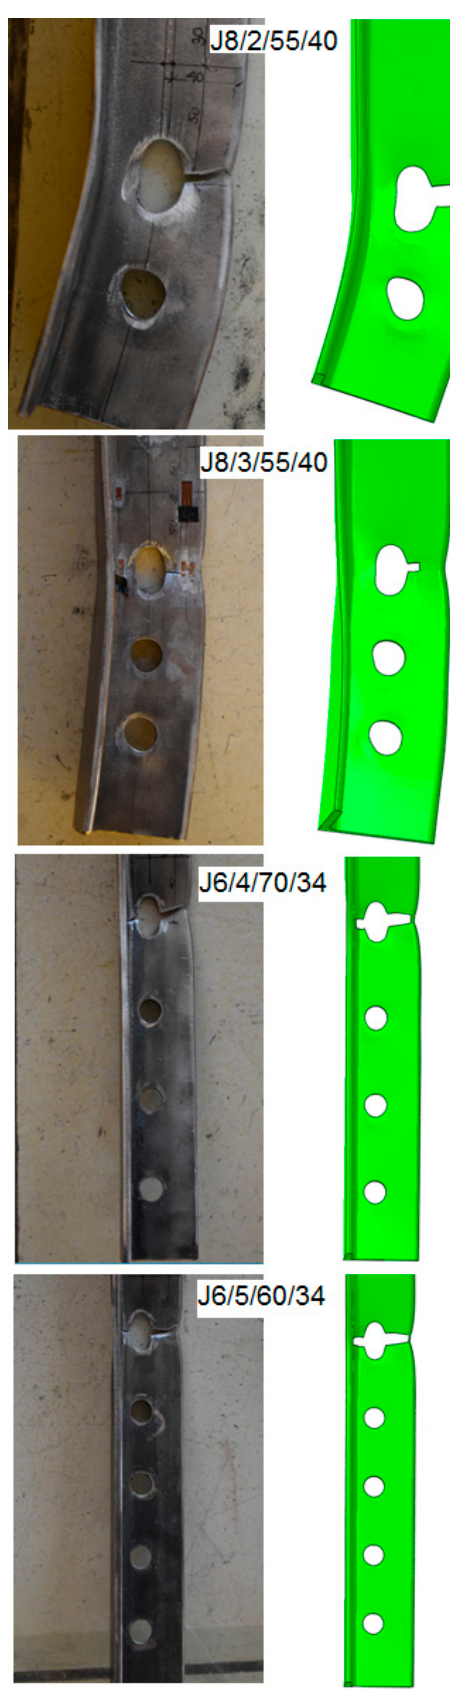
Figure 12. Comparison of failure modes observed in testing and FE modelling.